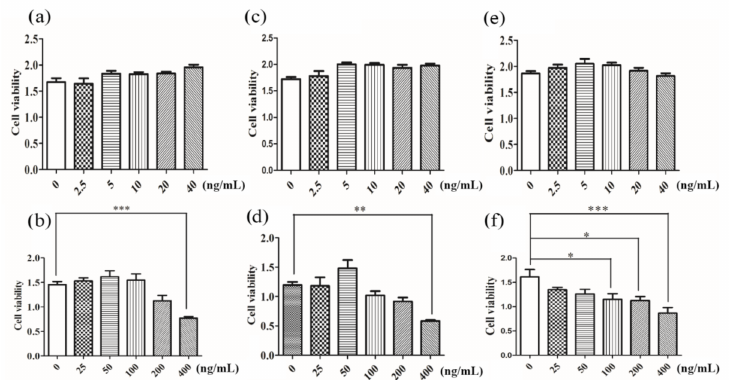
Figure 5. Cell viability assay of Fe 2 O 3 /Fe 3 O 4 heterogeneous nanoparticles calcined at various temperatures: ( a , b ) 250, ( c , d ) 300, and ( e , f ) 350 ◦ C. * p ≤ 0.05, ** p ≤ 0.01, *** p ≤ 0.001 versus control group, n =